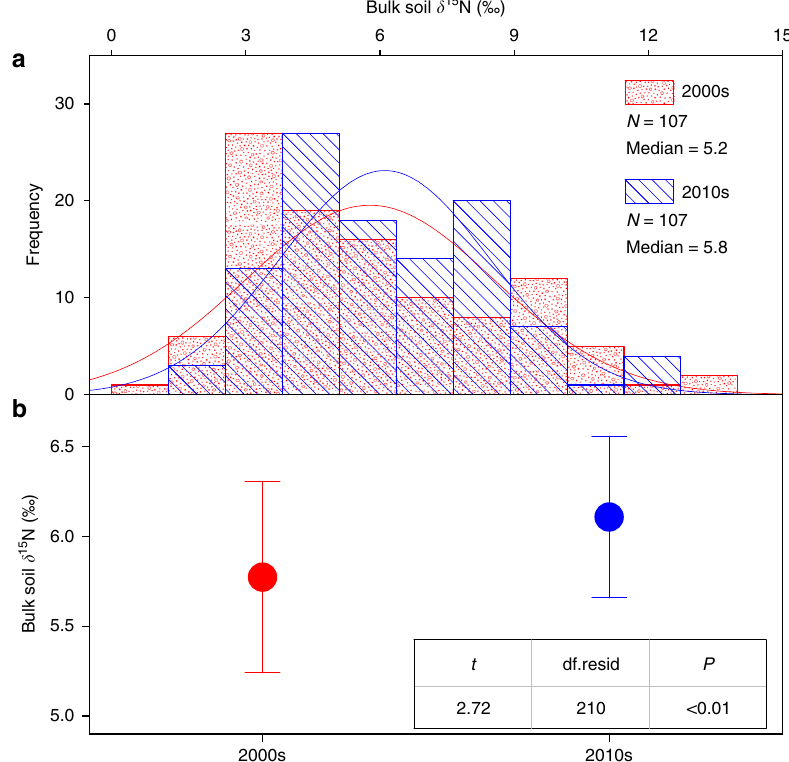
Fig. 4 Changes in topsoil δ 15 N over 2000s ~ 2010s. a , b Frequency distributions of bulk soil δ 15 N and changes in bulk soil δ 15 N during the period between the 2000s and the 2010s, respectively. The change in bulk soil δ 15 N was examined with linear mixed-effects model, in which the fi xed effect was year and the random effect was sampling site. Points in b denote mean values and error bars represent 95% con fi dence intervals. N , the number of sites used for analyzing bulk soil δ 15 N; Median, median value of bulk soil δ 15 N; df.resid, residual degrees of